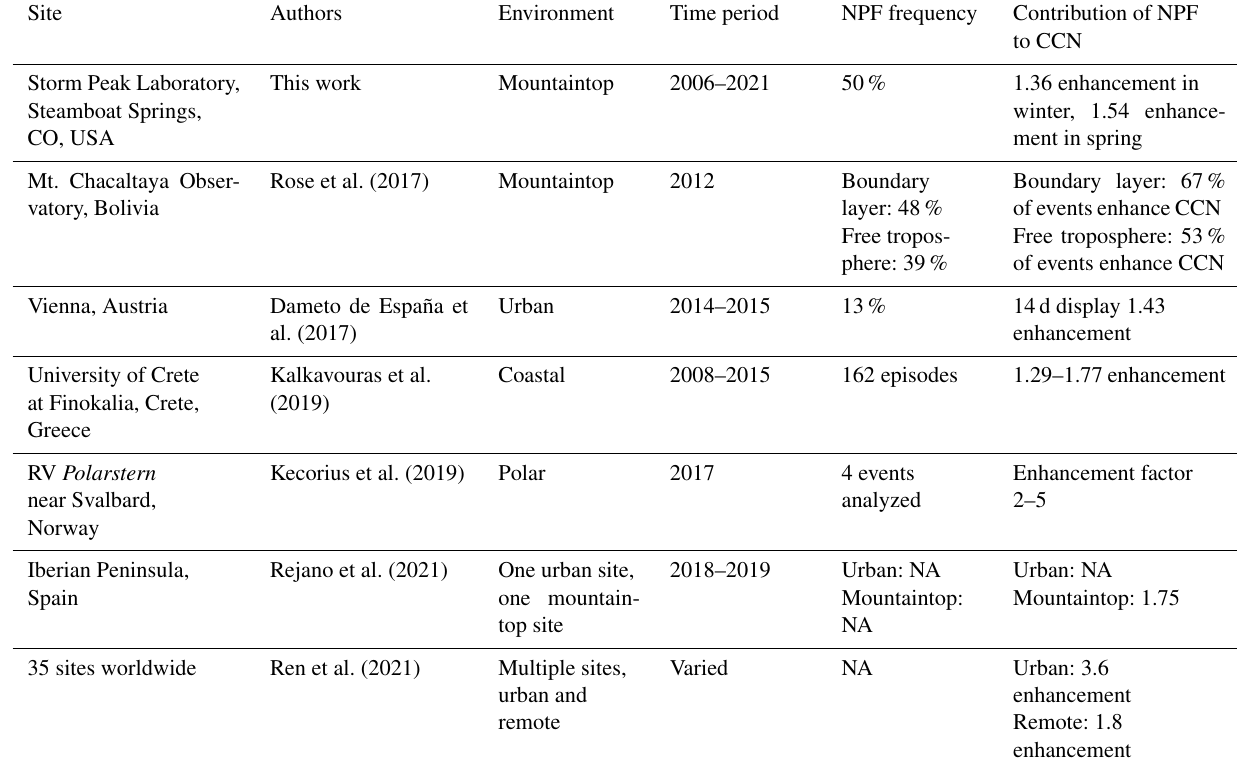
Table 3. Details of multiple studies that find the enhancement of CCN by NPF using observational data. For a study to be included on this list, an enhancement percentage or factor of CCN due to NPF must be calculated.